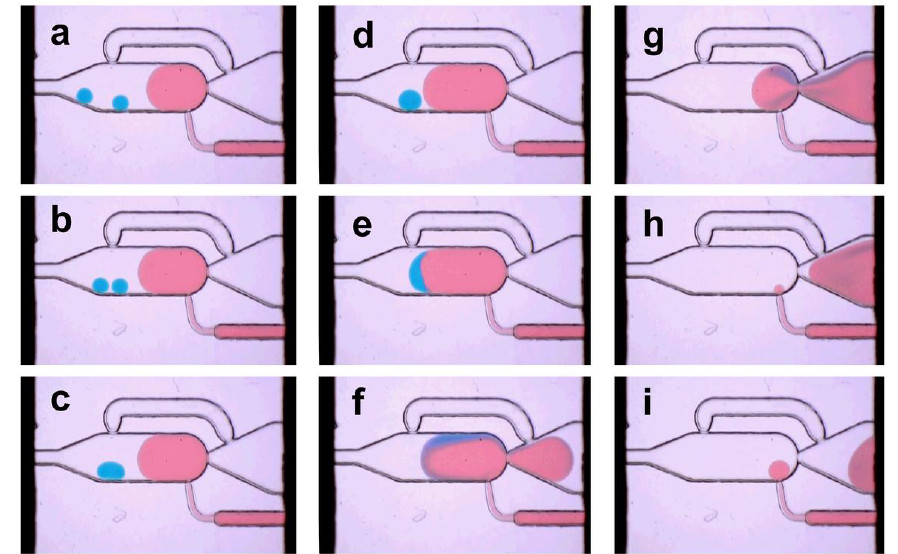
Figure 6. Image series of the multiple-droplet dilution mode (Figure 2C): Two 40 nL droplets (blue dyed) were diluted to about 550 nL ( a ). The dilution media (red dyed) is feed into the chamber in parallel. The electrocoalescence is permanently on and cause the fusion if the boundaries get in touch ( b – c ) and ( d – e ). The expanded droplet blocks the bypass and initiates the release from the chamber, which is forced by the flow of the carrier medium ( e – h ) (frame rate 3 Hz).